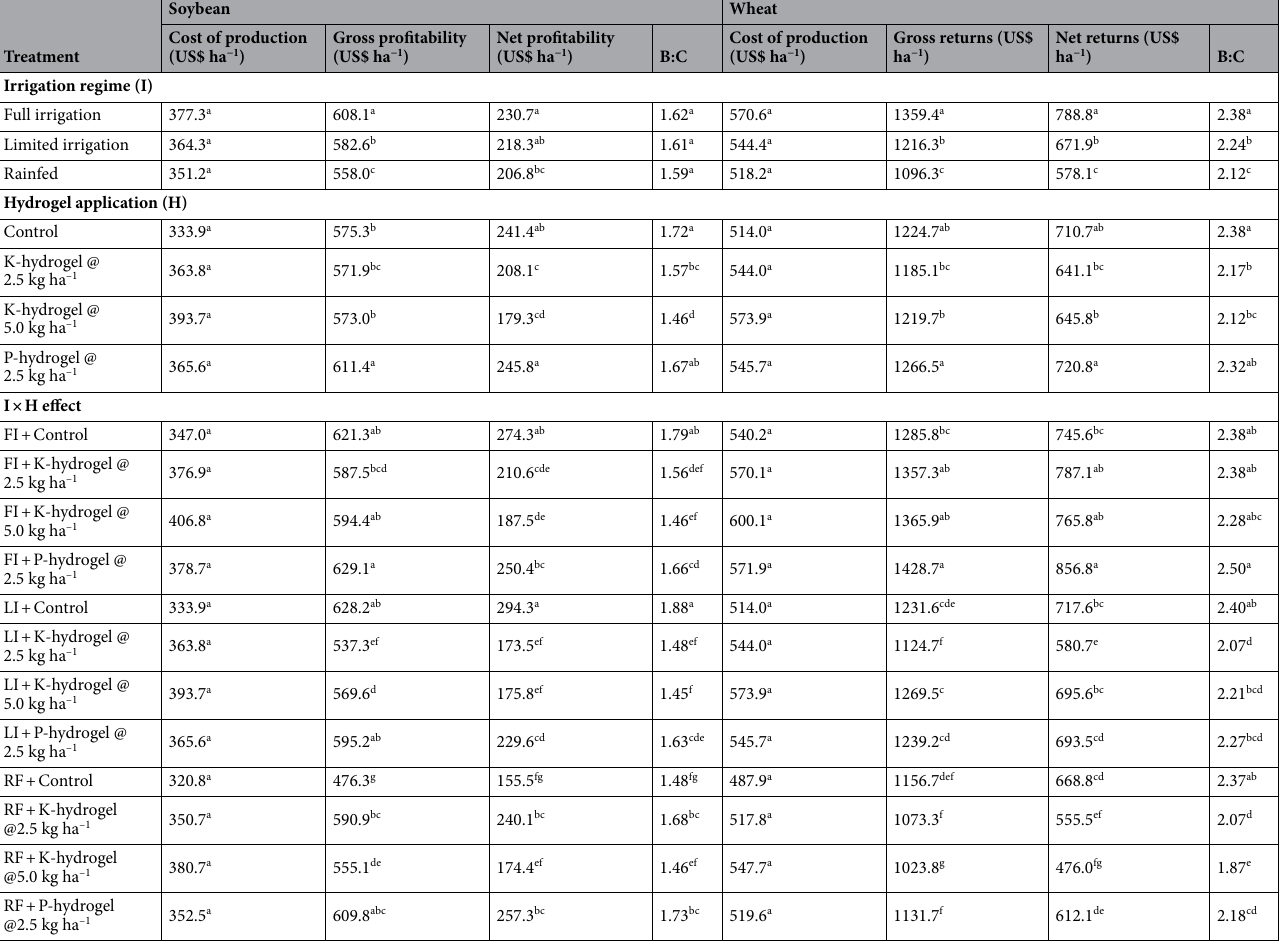
Table 3. Effect of hydrogels and moisture stress conditions on economics of soybean and wheat production in 2018–19. Means followed by a similar superscript letter within a column are not significantly different (at P ≤ 0.05) between treatments allowing to least significant difference test. Superscripts denotes the superior of the treatments i.e. a denotes best treatment followed by next best treatment b and so on. FI full irrigation, LI limited irrigation, RF rainfed, B:C benefit: